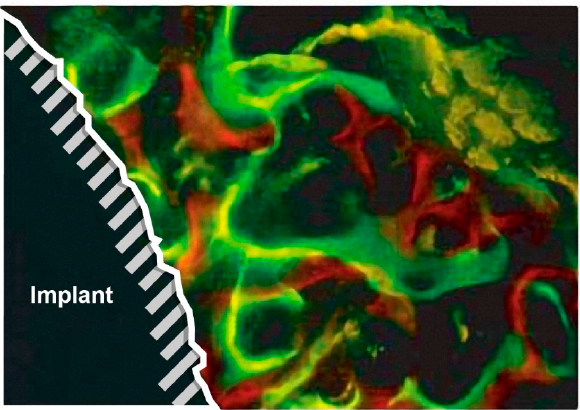
Figure 18. Fluorescence microscopy image of the bone compressed by the implant interface. Labeling with oxytetracycline (green/yellow) and alizarin complexion (red). Registered after two weeks of healing. Blue filter, ×40 magnification. Figure adapted with permission from [144].